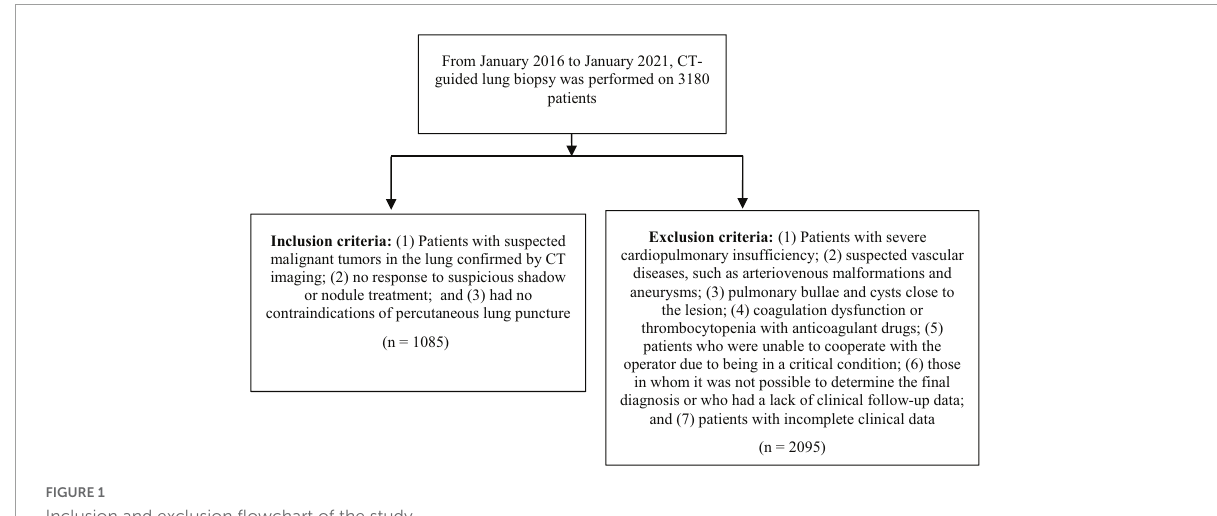
FIGURE1 Inclusion and exclusion flowchart of the